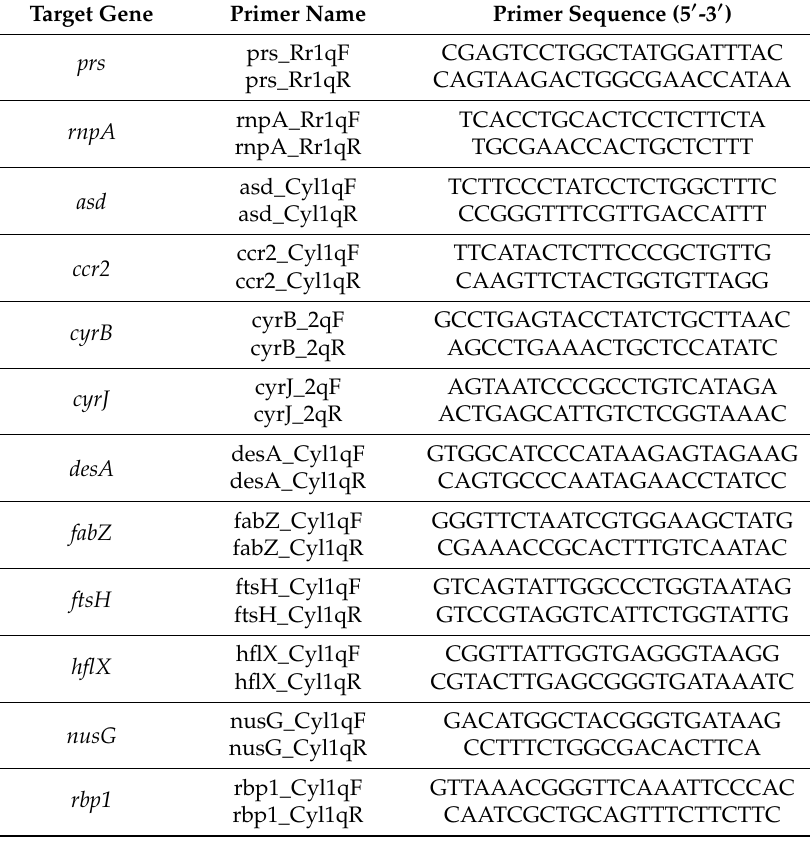
Table 1. List of primers used in the qPCR